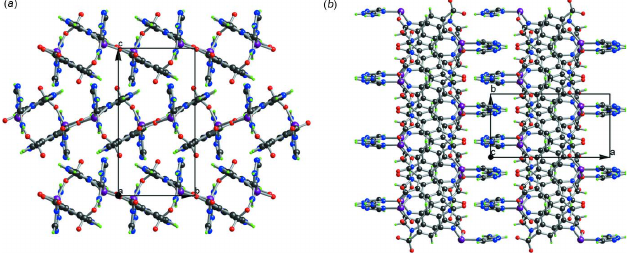
Figure 3 Structure of the title coordination polymer viewed along the ( a ) a axis and ( b ) c axis, respectively.